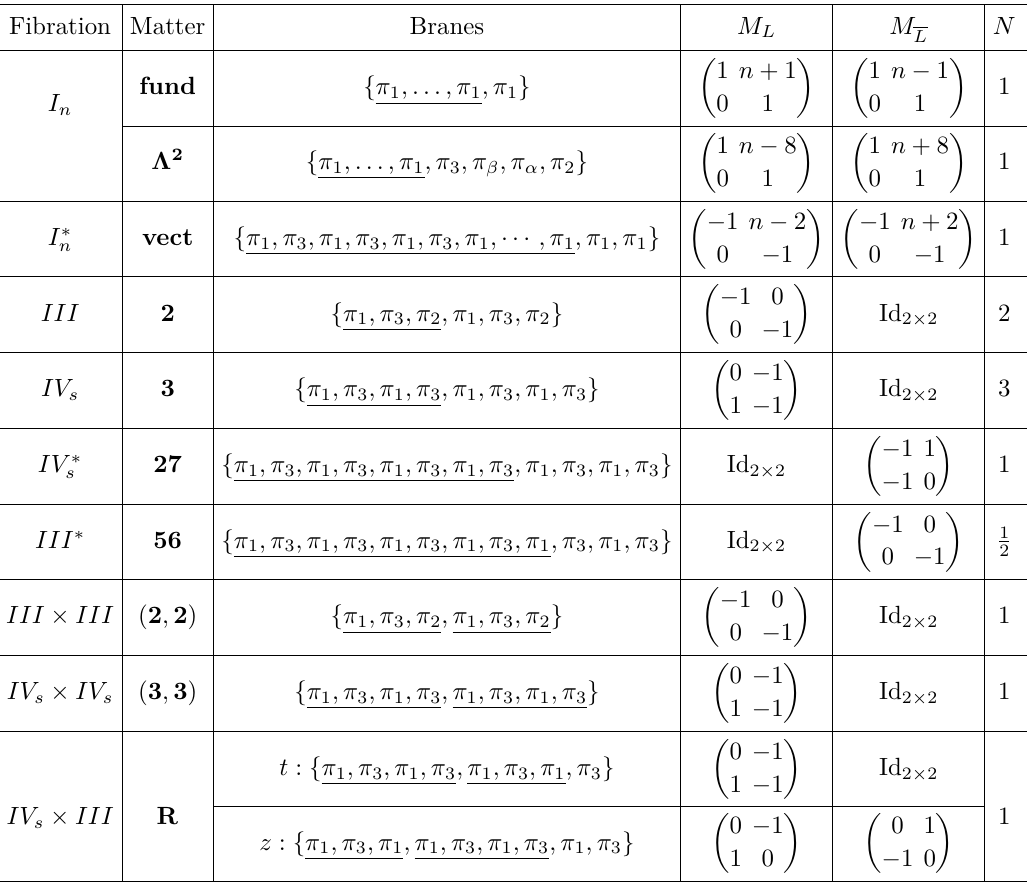
Table 1 . Summary of results. In each case we list the branes intersecting at the codimension 2 locus where the charged matters are localized and the monodromies corresponding to the branes. N is the multiplicity of the matter in the representation as listed in the second column of the table. The branes that carry the gauge algebra are underlined in the third column of the table. In the IV case R = ( 3 , 2 ) + ( 3 , 1 ) + ( 1 , 2 ) and we will consider the brane contents and the s × III monodromies on the t and z slices respectively and show that the results are consistent and match the anomaly cancellation condition in section